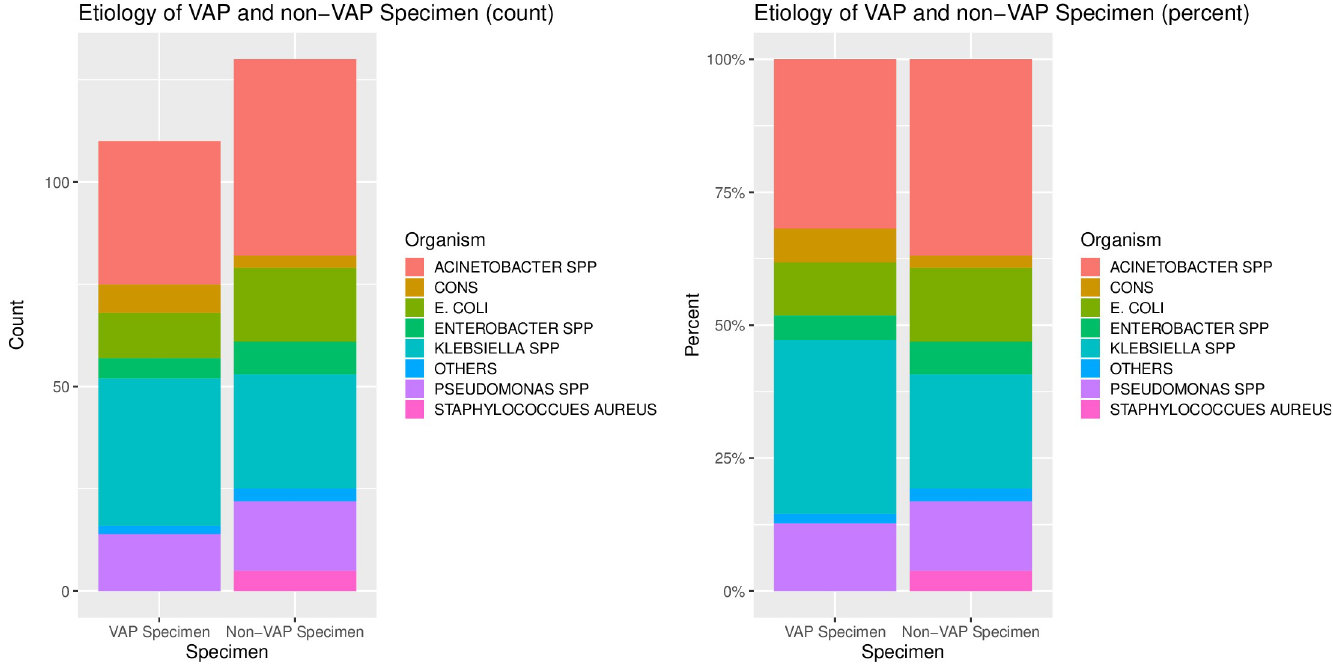
Fig 4. Etiology of VAP and non-VAP specimen.